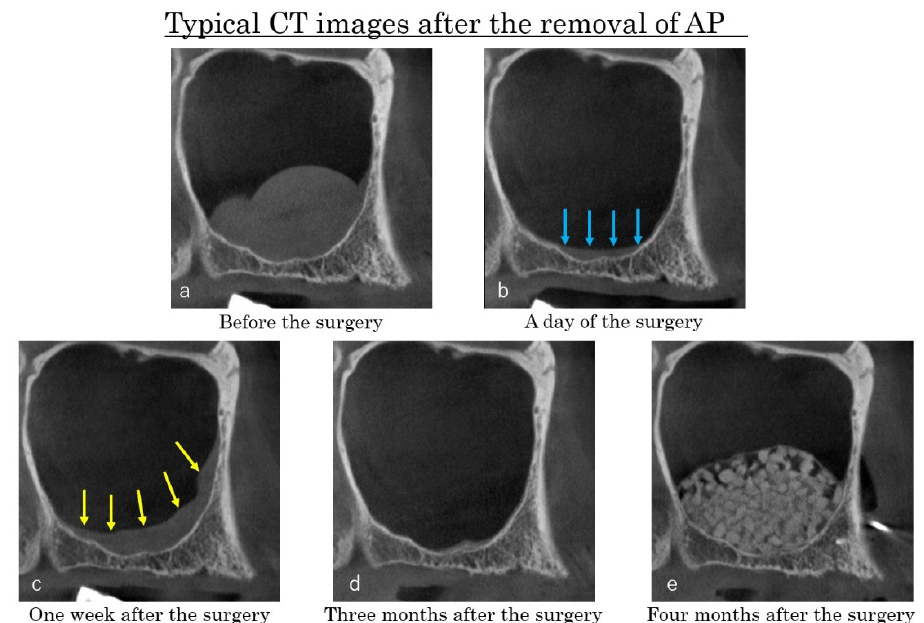
Figure 8. Case: 62 years old female. Two APs were detected on the CBCT before surgery ( a ). The cysts were removed, and the flat shaped faint opacity at the bottom of maxillary sinus was observed on the CBCT taken immediately after the surgery (( b ), blue arrows). One week after the surgery, a post-operative swelling of the sinus membrane was observed (( c ), yellow arrows). The swelling had disappeared three months after the surgery ( d ), and the sinus floor augmentation was performed successfully four months after the removal of Aps ( e ).